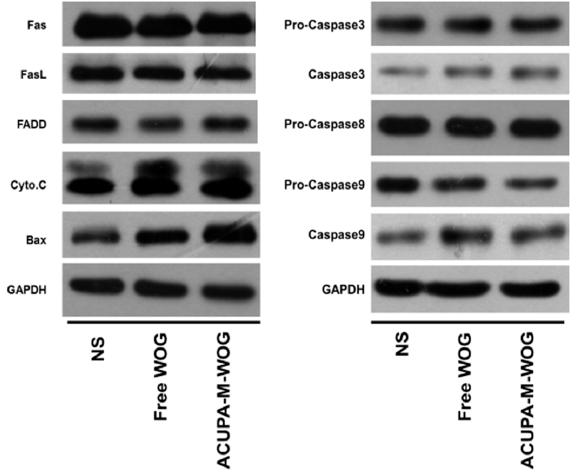
Figure 8. Free WOG or ACUPA-M-WOG induces apoptosis through the intrinsic pathway in PSMA (+) LNCaP cells, which is verified by WB (Western blot). GAPDH (glyceraldehyde phosphate dehydrogenase) served as a control.